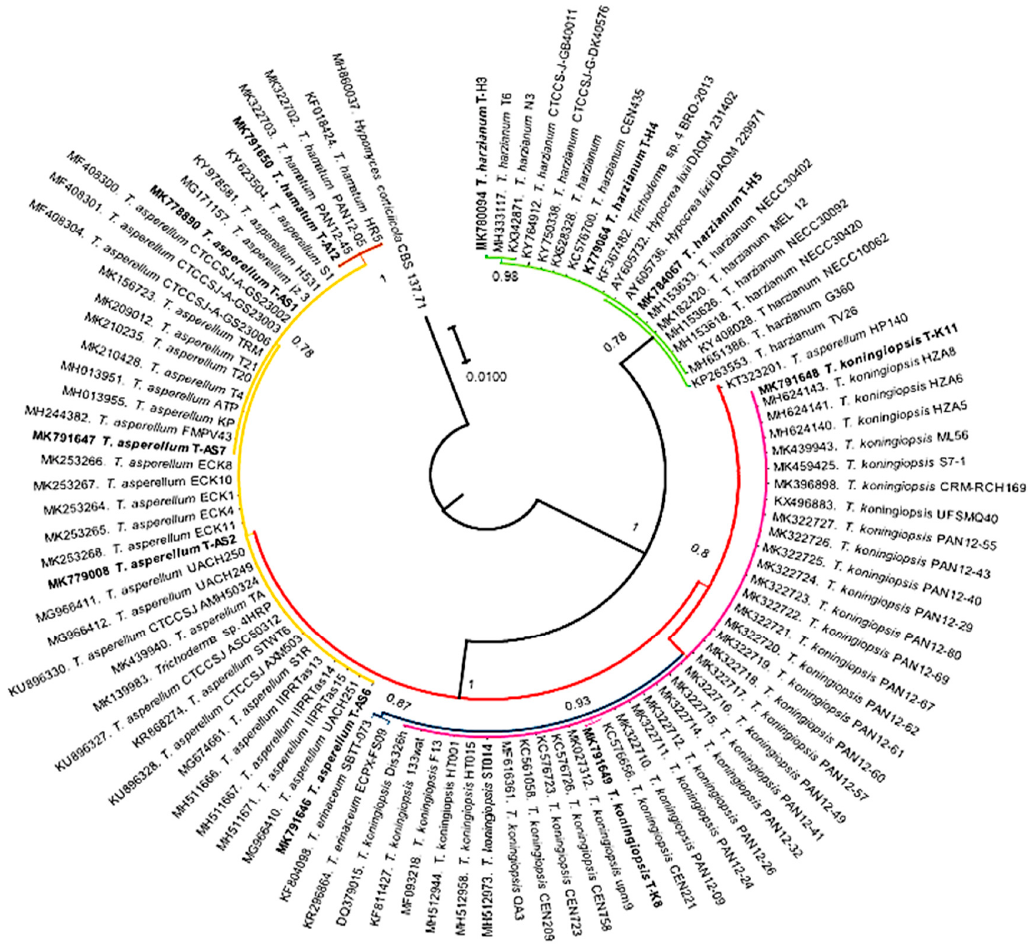
Figure 3. Phylogenetic tree constructed with sequences corresponding to the internal transcribed spacer region of indigenous species of Trichoderma and related sequences. The Bayesian inference method using the General Time Reversible substitution model was implemented with two million generations with a final standard deviation of < 0.01. Hypomyces corticiicola was considered as an outgroup.